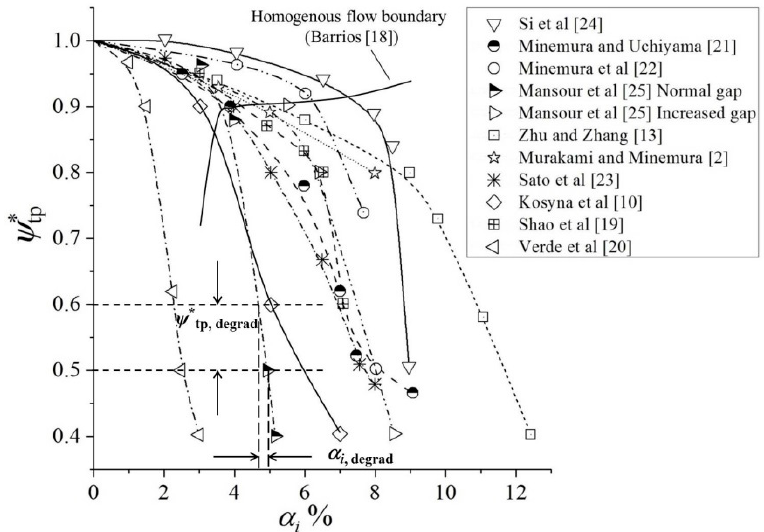
Figure 2. Pump head degradation ratio curves versus inlet void fraction (Worked out from experimental results given in Table 1).